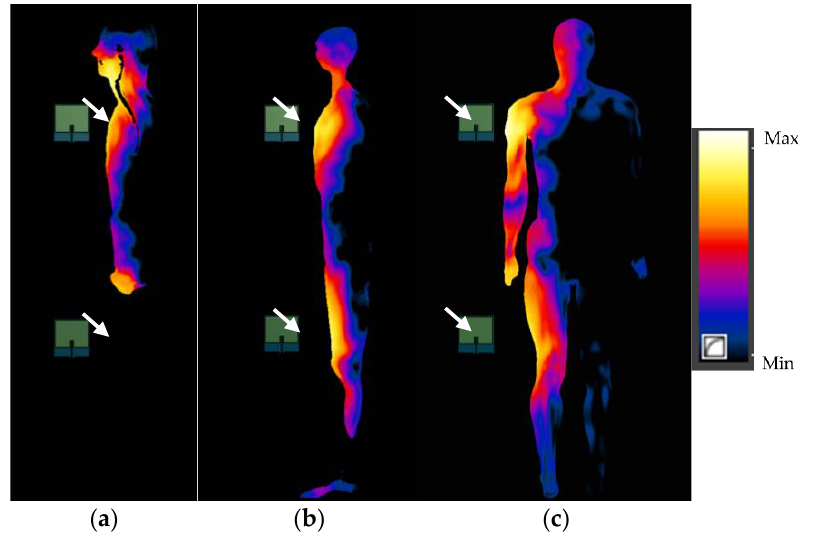
Figure 6. SAR distributions in the human body exposed to EMF near a UHF I-RFID two-antenna reader located 5 cm from the body: ( a , b ) in the body’s sagittal cross-sections through the body’s main axis and 6 cm to side (through the leg) in scenario EF and ( c ) in the body’s frontal cross-section in scenario ES; antennas marked with white arrows.